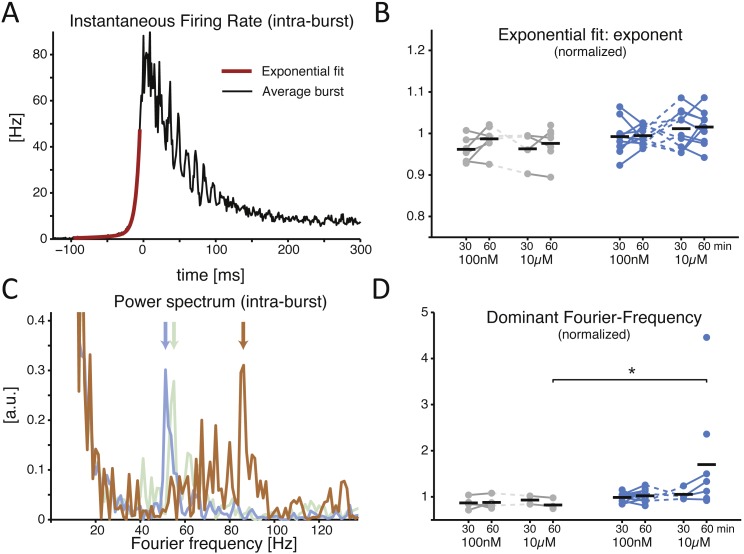
The SP inhibitor alters the features of the network burst at its offset, not onset.A representative example of the average instantaneous firing rate during a NB is displayed (A), estimated by a spike time histogram (STH). At onset the time course is best fit by an exponential function, while at offset it is often (not always) characterised by intra-burst oscillations. When the exponential onset increase in the firing rate is quantified, (B) by comparing the exponent of the best fit rising phase of the STH, normalised to baseline, the application of the inhibitor revealed no effect (black horizontal bars indicate the group averages). The power spectrum of the offset of the STH (C) quantifies an obvious transient oscillatory behaviour: coloured traces show the power spectrum density (PSD) for the baseline (grey), 100 nM (blue), and 10 µM (orange) for the same MEA, and the location by a coloured arrow of the dominant frequency. When the latter is normalised to baseline and compared across conditions, a significant increase is found at the high dose of the inhibitor (D).